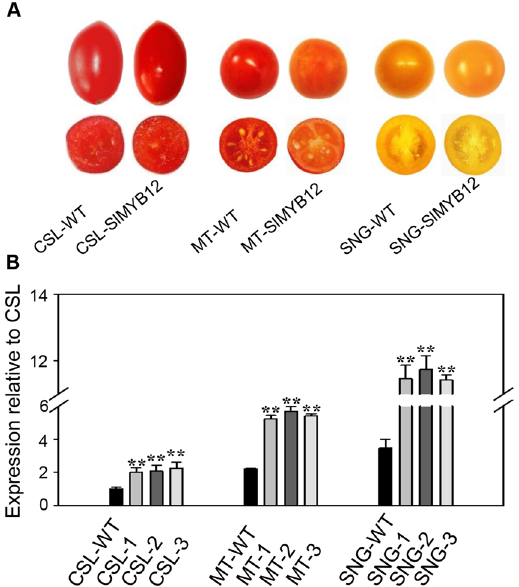
Figure 4. Phenotypes of wild-type and SlMYB12 -overexpressing tomatoes. ( A ) Phenotype of SlMYB12 expression in three tomato varieties. Control fruit (left) and SlMYB12 -overexpressing plant (right). CSL-WT, Csl09-03 wild-type; CSL-SlMYB12, Csl09-03 SlMYB12 -overexpressing tomato; MT, Micro-Tom wild-type; MT-SlMYB12, Micro-Tom SlMYB12 -overexpressing tomato; SNG, Sheng Nv-Guo wild-type; SNG-SlMYB12, Sheng Nv-Guo SlMYB12 -overexpressing tomato. ( B ) Relative expression levels of SlMYB12 in control and T 1 generation SlMYB12 transgenic tomatoes. Each value was normalized to SlMYB12 expression in wild-type Csl09-03 and is indicated as the mean ± standard deviation of three experimental replicates. CSL-1, CSL-2, CSL-3, MT-1, MT-2, MT-3, SNG-1, SNG-2, and SNG-3 indicate the T 1 heterozygous lines of each variety. ** P <